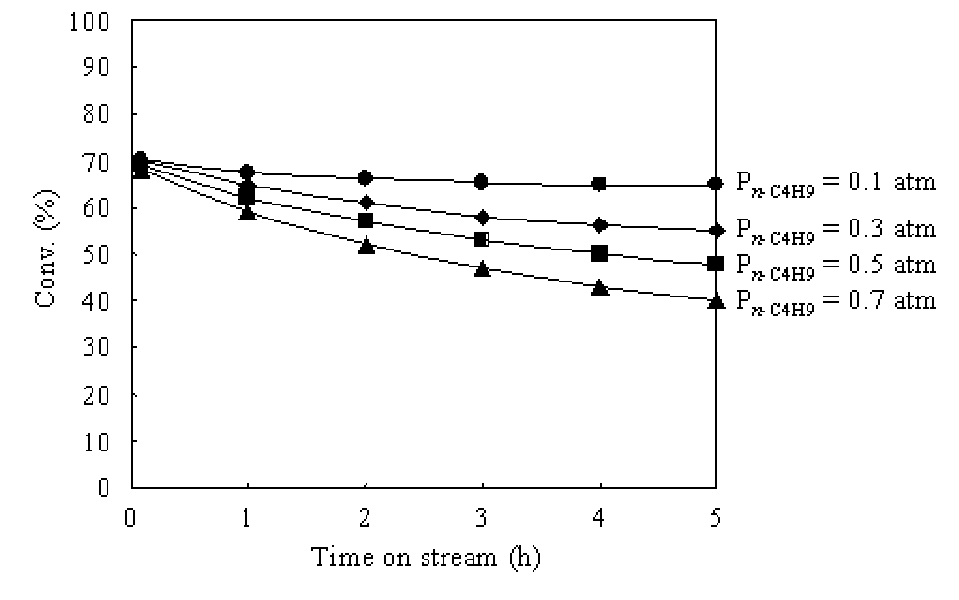
O +Cs2.5 at 573 K 2 3